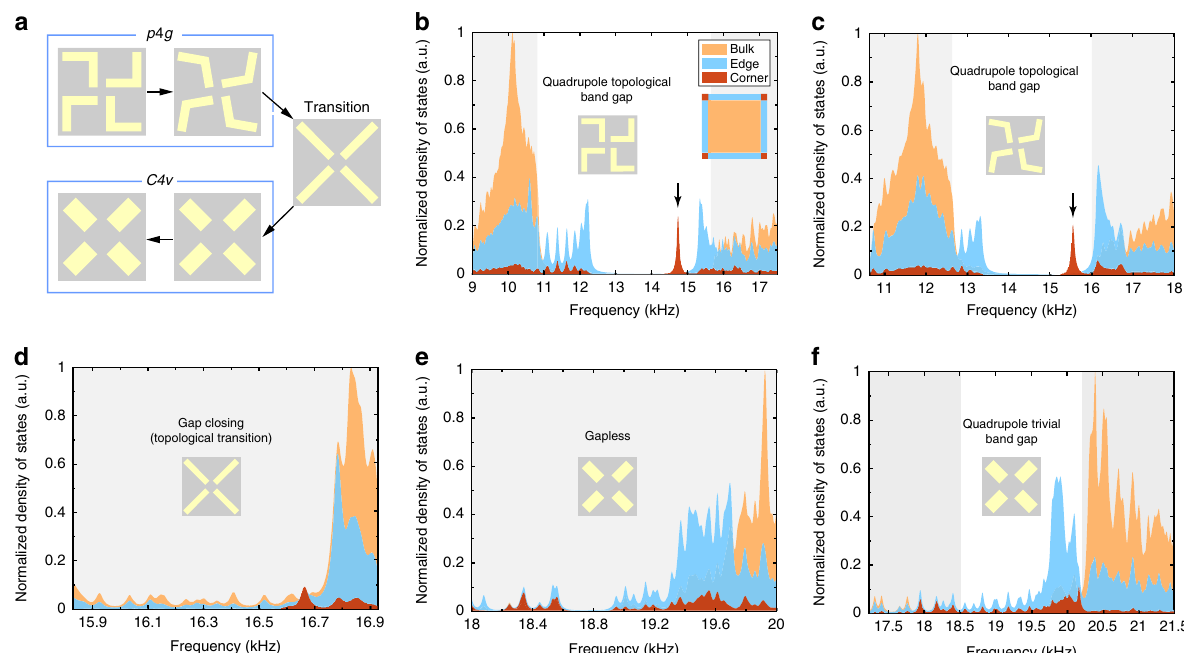
Fig. 2 Topological phase transitions in the second band gap. a Topological phase transitions induced by continuously tuning the geometry (indicated by the arrows): fi rst decrease the arch height h to 0 (the fi rst three structures), then reduce the length l (the fourth structure), and fi nally increase the width w (the fi fth structure). The corresponding geometric parameters are h = 0.21 a , l = 0.42 a , w = 0.1 a for the fi rst structure; h = 0.15 a , l = 0.42 a , w = 0.1 a for the second structure; h = 0, l = 0.42 a , w = 0.1 a for the third structure; h = 0, l = 0.25 a , w = 0.18 a for the fourth structure; and h = 0, l = 0.25 a , w = 0.21 a for the fi fth structure. The fi rst two structures have p 4 g symmetry, whereas the others have C 4 v symmetry. b – f Calculated local density-of-states for the corner, edge, and bulk regions. The densities-of-states are normalized so that the peak values in the fi gures are 1. Here, a.u. stands for arbitrary units. The corner, edge, and bulk regions are sketched in the inset of b . The calculations are performed on a box-shaped fi nite structure consisting of 10 × 10 sonic crystal unit cells enclosed by hard-wall boundaries. An air channel of width 0.25 a separates the sonic crystal and the hard-wall boundaries to ensure the physical edges and corners for the acoustic